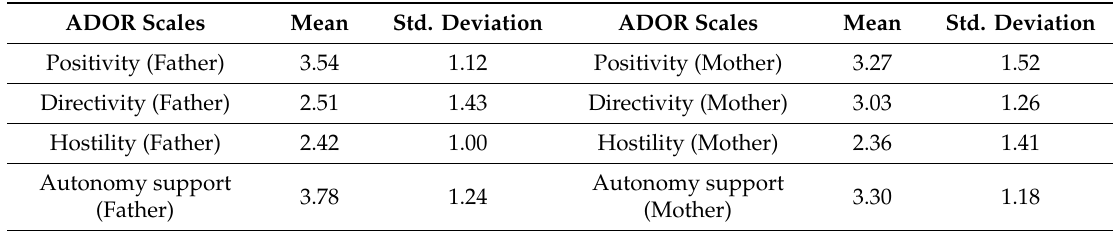
Table 4. Descriptive statistics for communicative characteristics of the mother and the